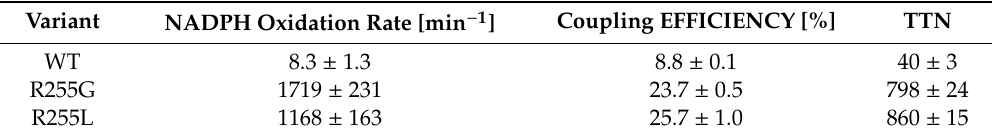
Table 1. Catalytic performance of benzo-1,4-dioxane conversion with purified P450 BM3 WT and variants R255G and R255L.